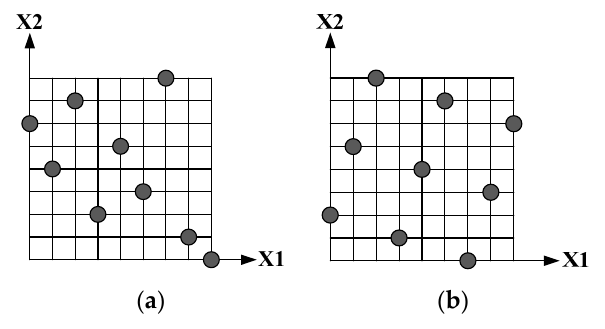
Figure 3. Latin Hypercube Design. ( a ) Random Latin hypercube and ( b ) optimal Latin hypercube.